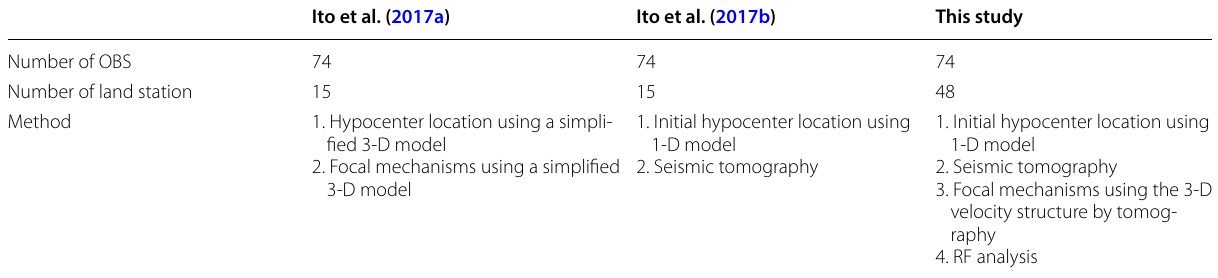
Table 1 Specifications and observational periods of the stations Ito et al. (2017a) This